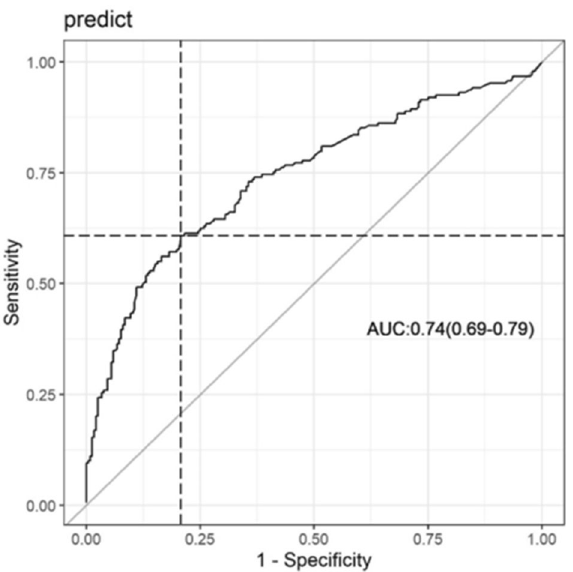
Figure 3. ROC curve of the model to predict postoperative stay > 5 days after cardiac